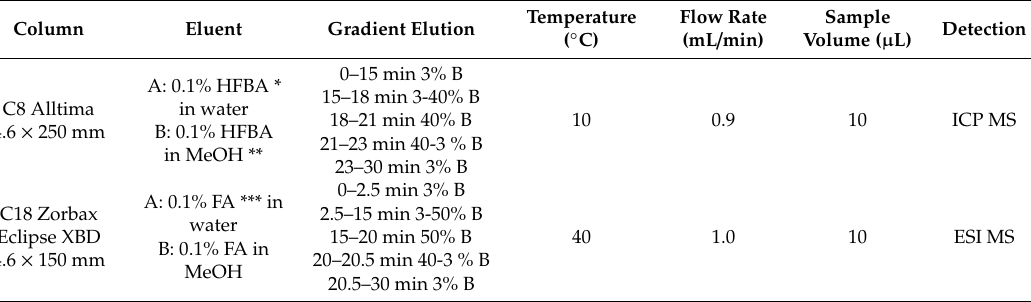
Table 5. Chromatographic Conditions